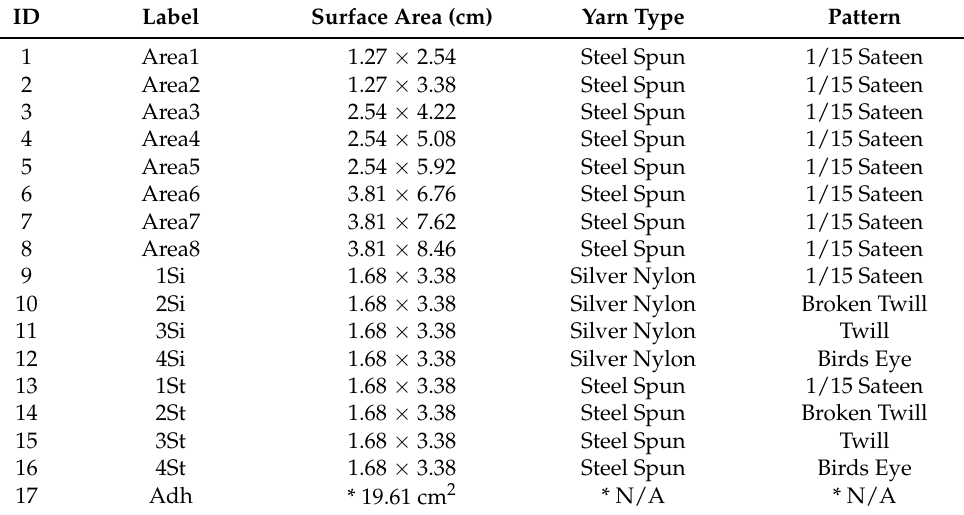
Table 1. Electrode manufacturing